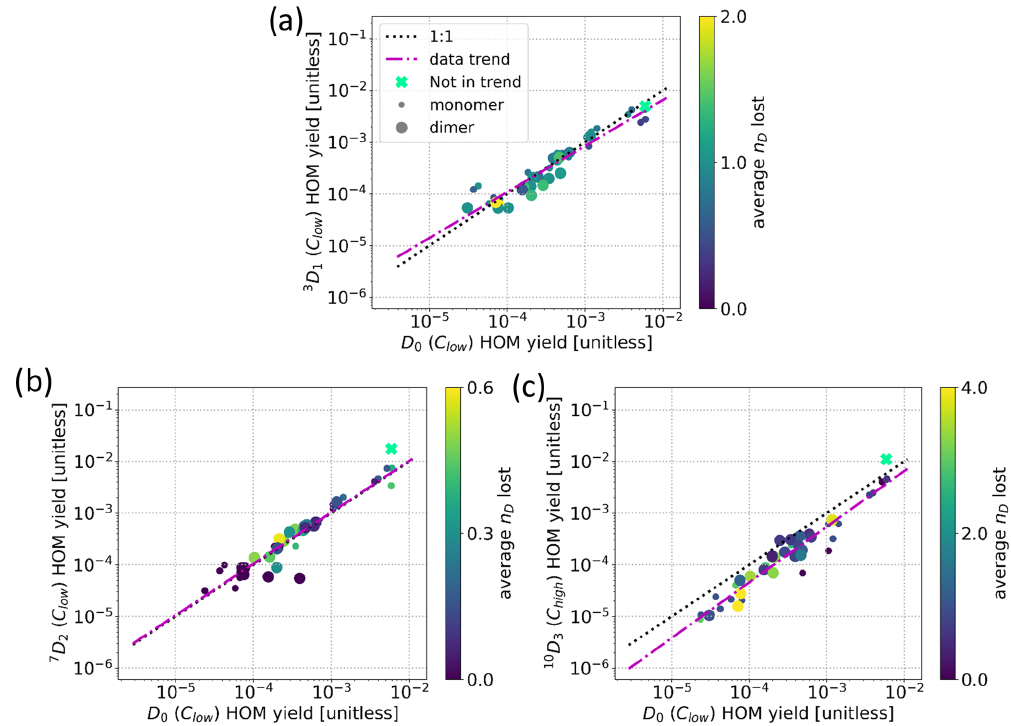
Figure A4. Comparison of HOM yields compound per compound with the number of deuterium atoms lost on average shown with the colour between the D 0 sample and the 3 D 1 sample (a) , the 7 D 2 sample (b) , and the 10 D 3 sample (c) , where the mint green cross corresponds to C 5 H 6 O 7 and is excluded from the data trend. C low and C high refer to the α -pinene concentration of the sample. Note that each point corresponds to the yield of the sum of all found isotopes per main